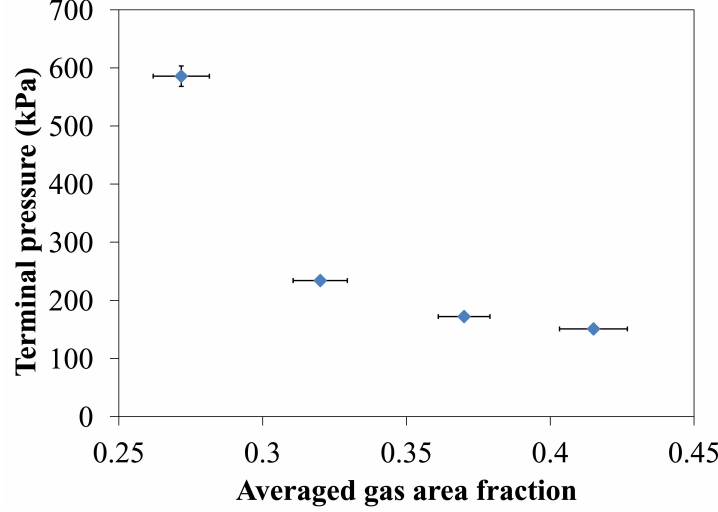
Figure 33. Effect of gas area fraction on terminal pressure. From Samaha et al.